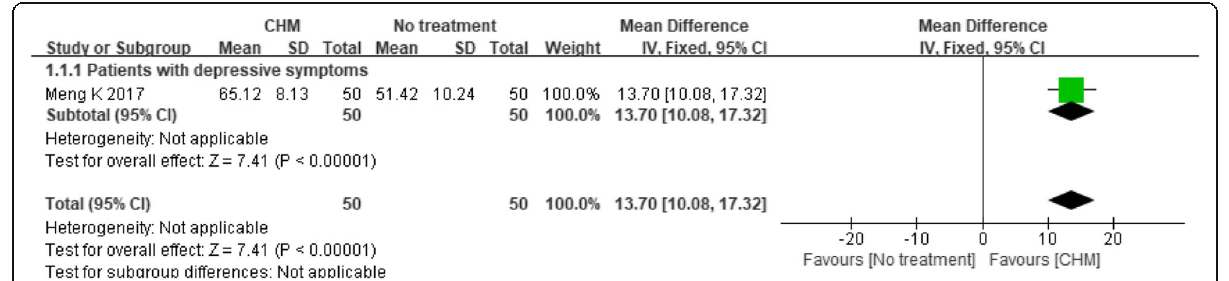
Fig. 11 Forest plot of the group mean quality of life scores for CHM versus no treatment